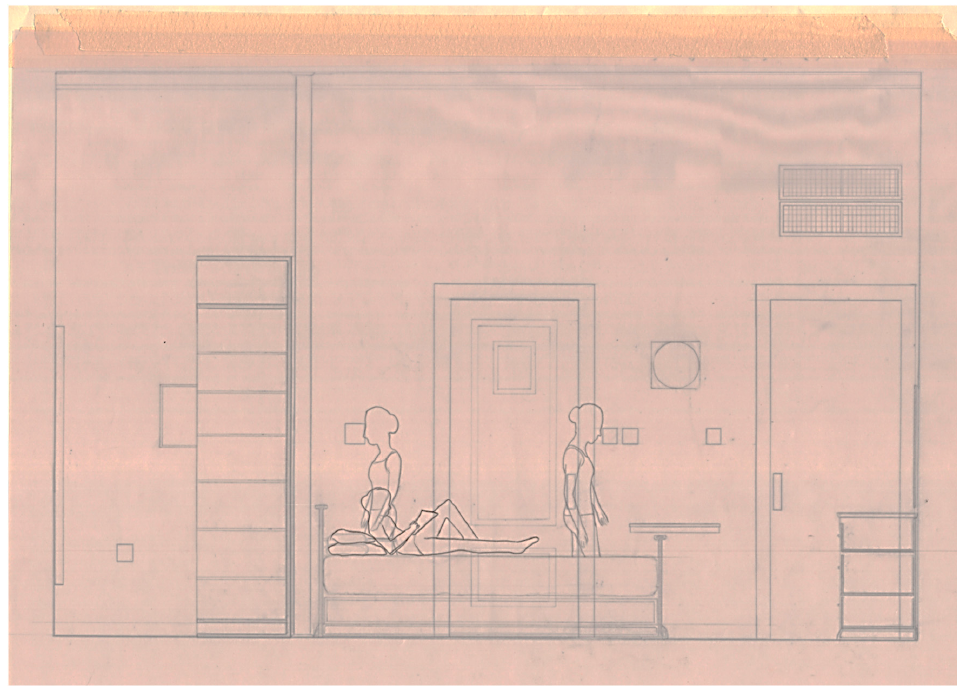
Figure 4. Two examples of layered elevation drawings.